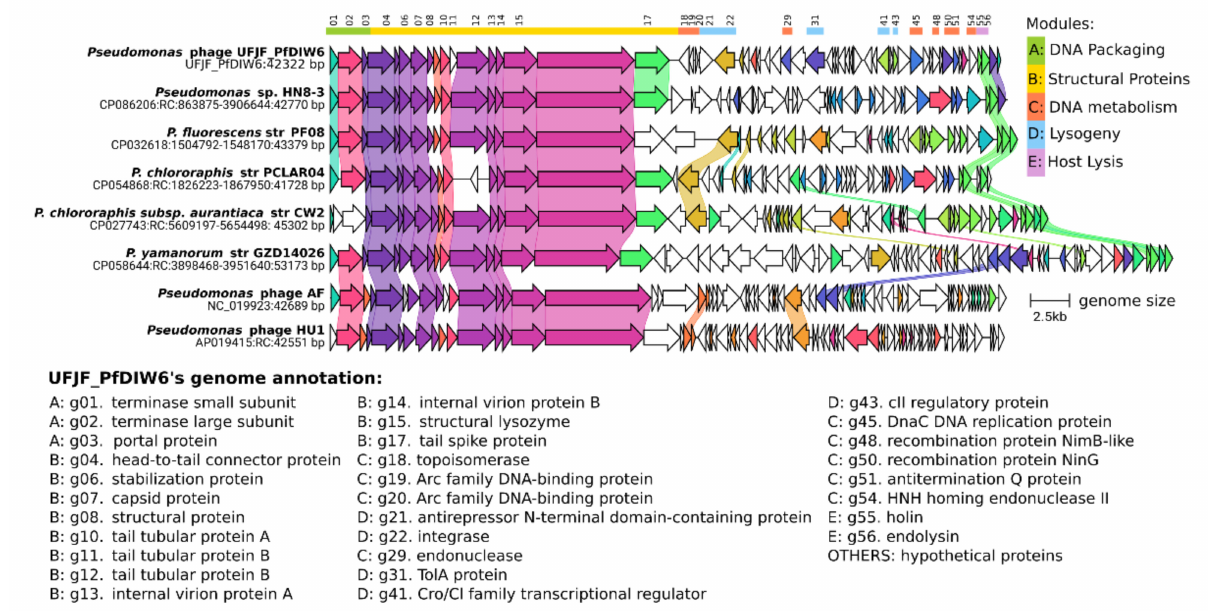
Figure 1. Genomic features of Pseudomonas phage UFJF_PfDIW6. UFJF_PfDIW6’s genome is shown above all others. Its sequence has a bidirectional organisation with 58 genes (represented by arrows) organised into five functional modules, represented by the coloured bars and indicated in the genes’ annotation list. The numbers above the arrows indicate the genes with predicted functions, shown in the annotation list. The arrow’s colours represent the gene clusters identified by Clinker, which encode similar proteins. The lines connecting the arrows represent gene-encoding proteins that share sequence identity more significant than